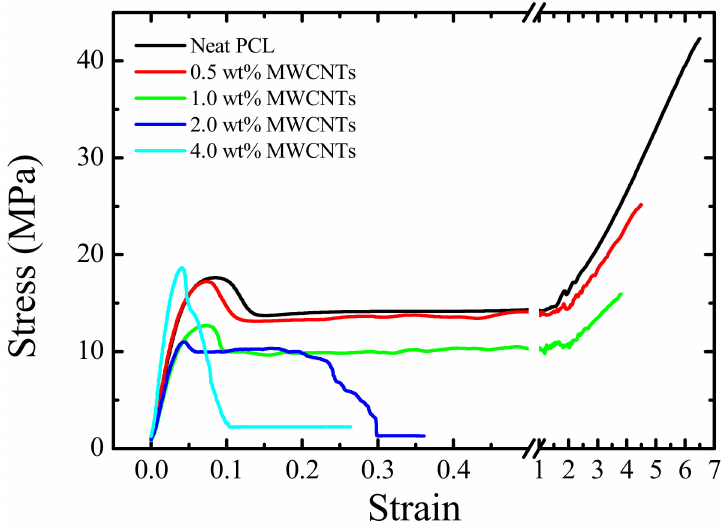
Figure 22. Stress–strain curves for neat PCL and the